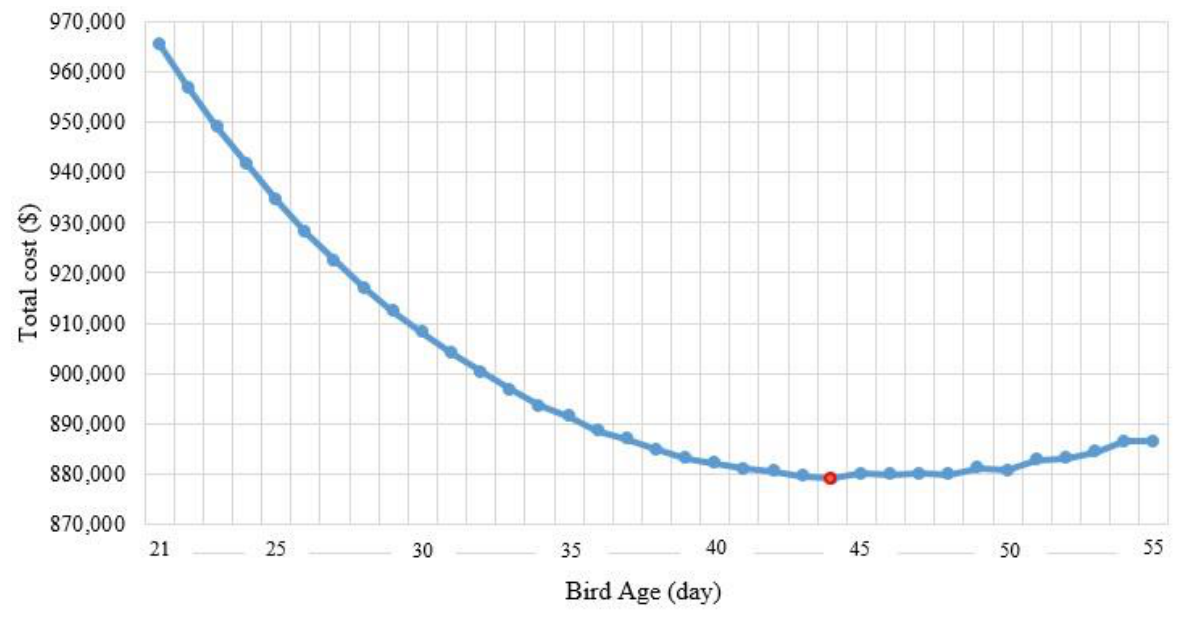
Figure 5. Carbon dioxide production curve.